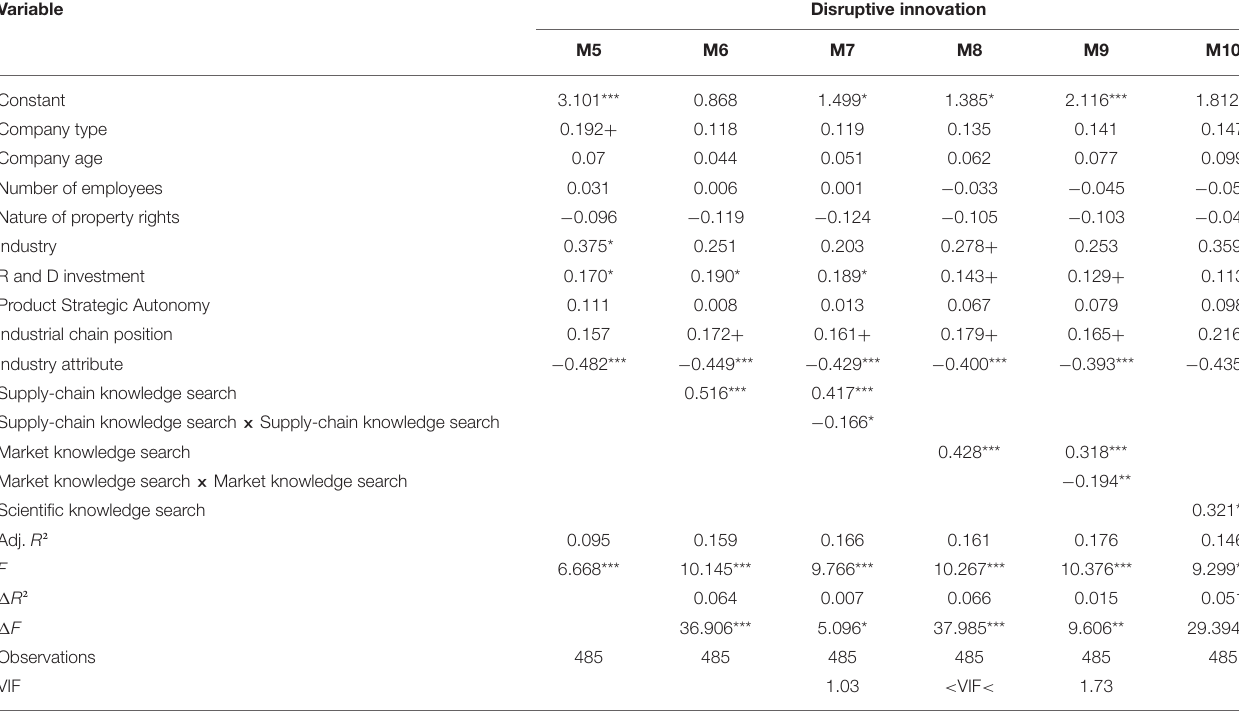
TABLE 6 | Regression results of knowledge search and disruptive